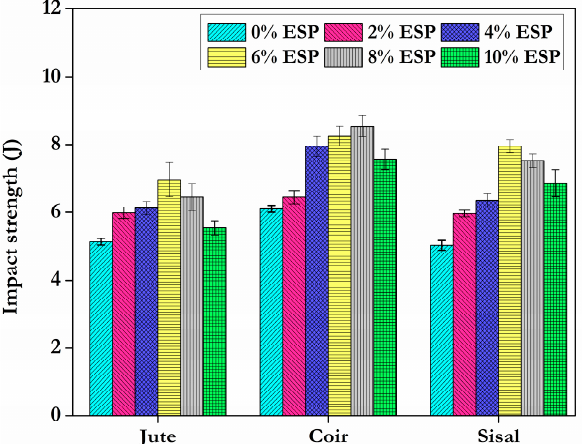
Figure 9. Impact load value of different fibres with varying proportions of ESP.